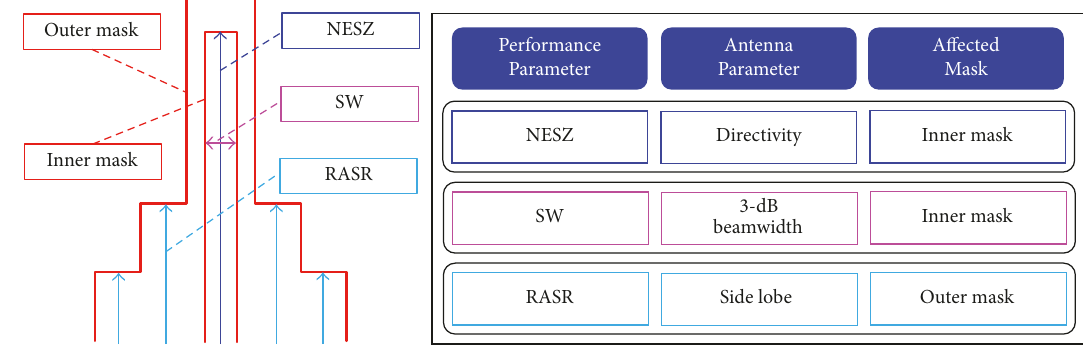
Figure 2: Relationship between SAR performance and antenna